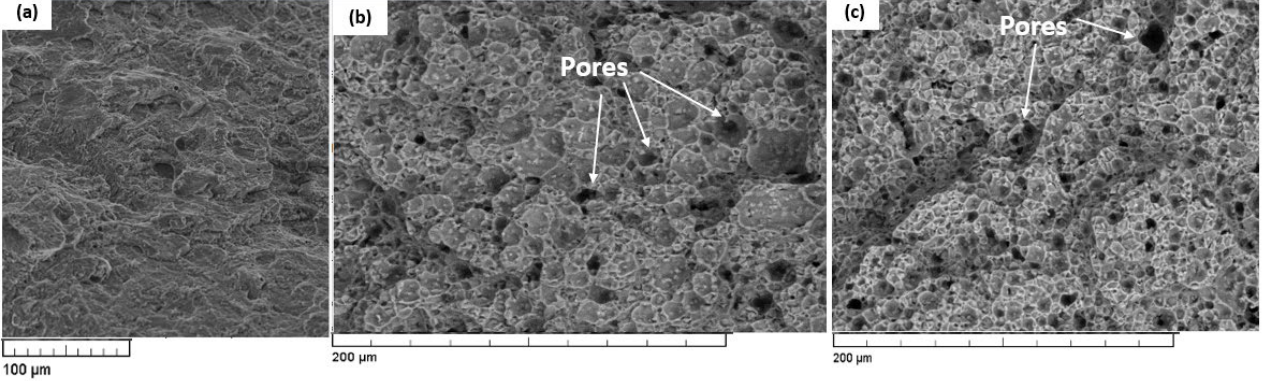
Figure 9. SEM images of fracture morphology of specimens ( a ) as-built ( b ) ST + AA at 140 °C and 12 h ( c ) ST + AA at 160 °C and 8 h.